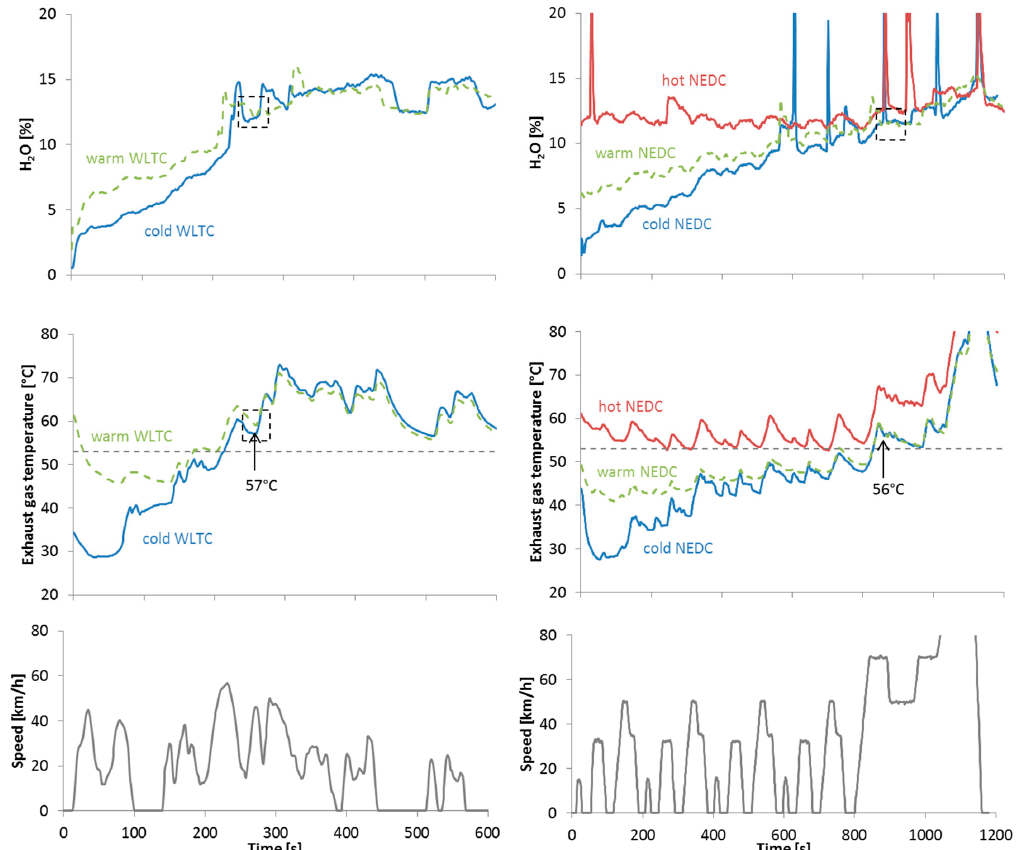
Figure 5. Vehicle Gasoline Direct Injection (G-DI). Left panels: First 600 s of WLTC. Right panels: NEDC (New European Driving Cycle). Upper: H 2 O concentrations. Middle: Exhaust gas temperatures. Low: Speed profiles. Dashed boxes indicate the time period where the H 2 O concentrations reached similar levels. The dashed line is the dew point of gasoline exhaust gas (53 °C).